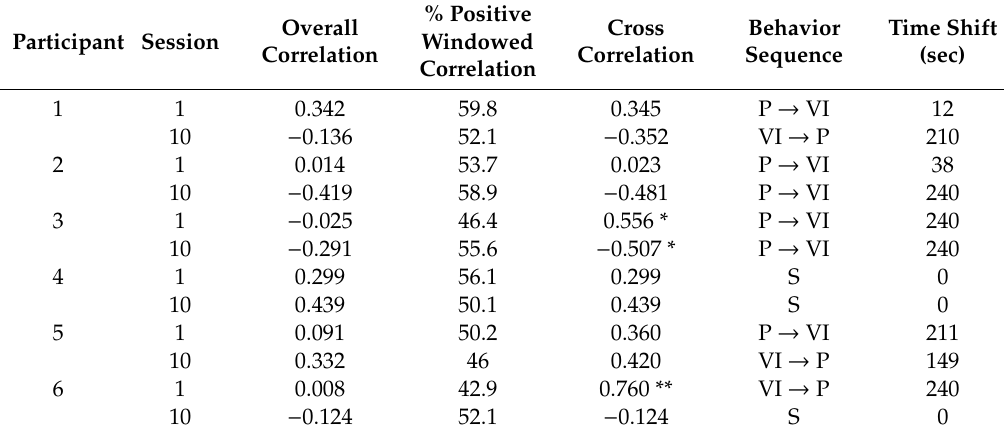
Table 3. Relations between verbal initiative and